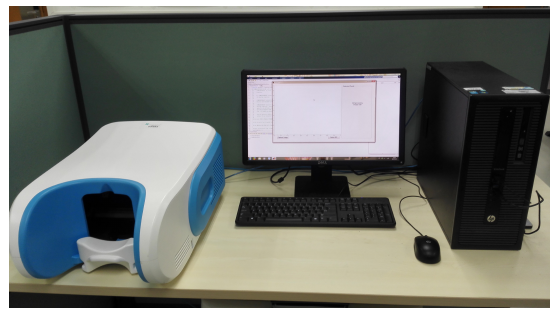
Figure 2. Facial image capture device.